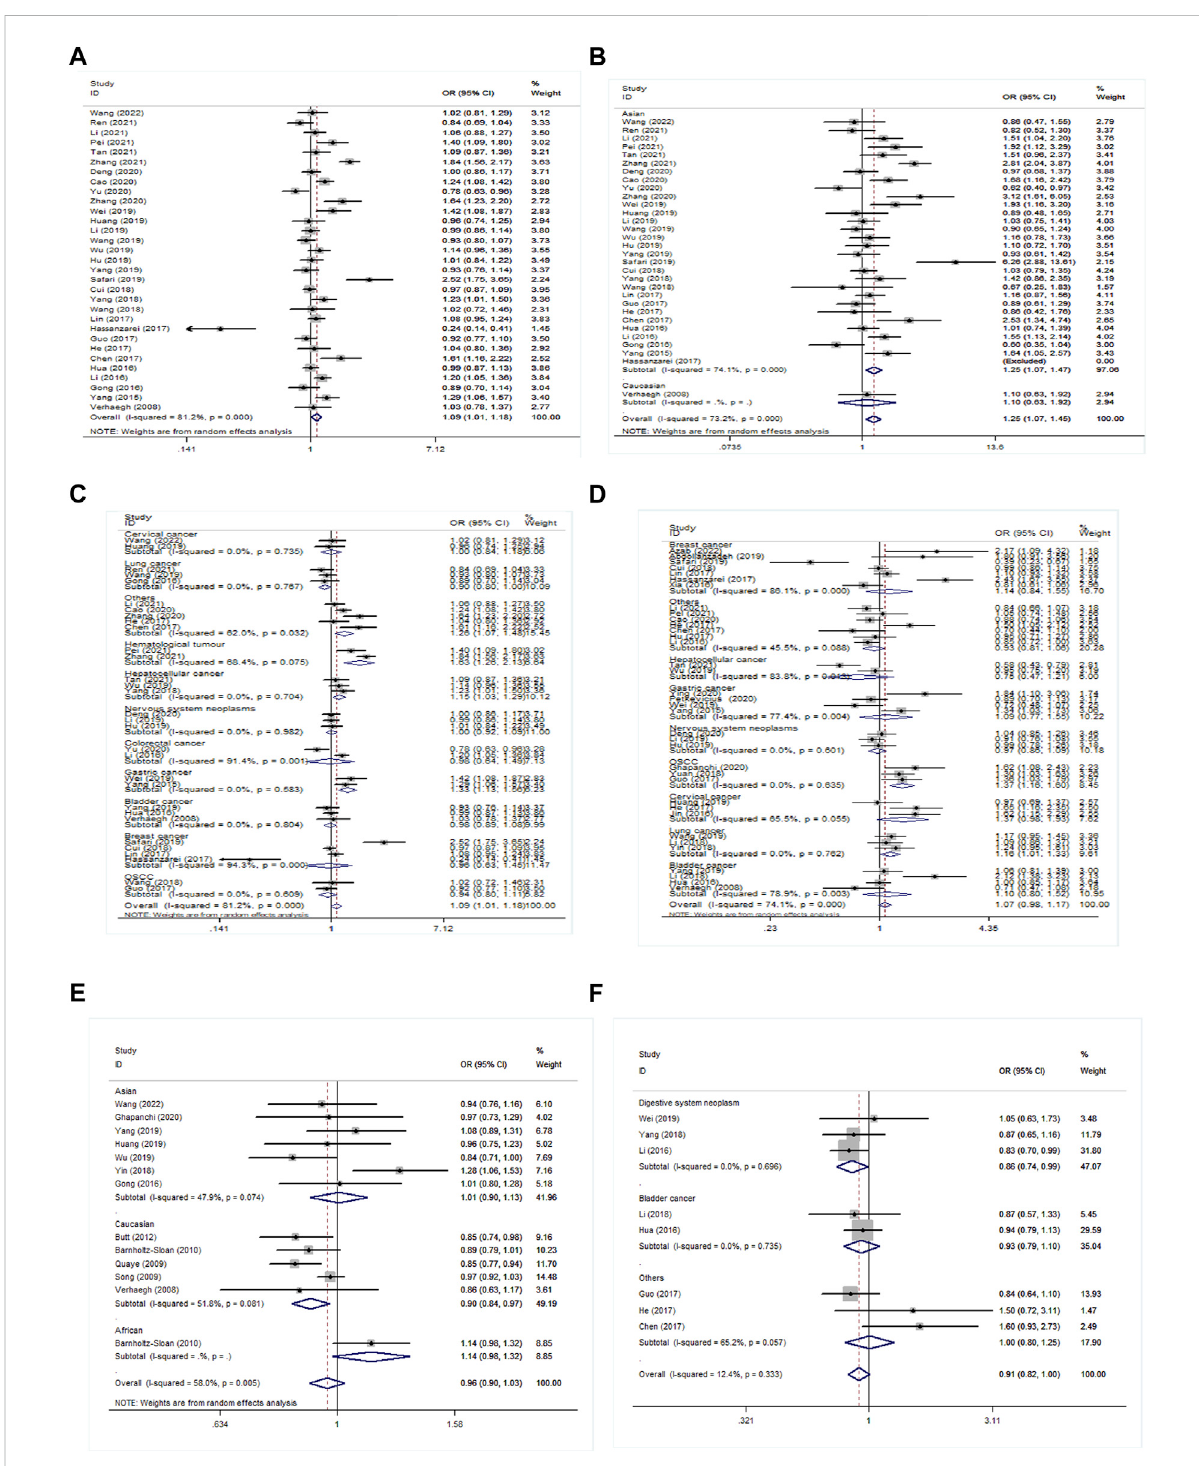
ForestplotfortheassociationbetweenH19polymorphismsandcancersusceptibility. (A) Forestplotforrs2839698polymorphismintheoverall population, A vs G; (B) in ethnicity subgroup, AA vs GG; (C) and in cancer type subgroup, A vs G; (D) for rs217727 polymorphism in cancer type subgroup,AA+AGvsGG; (E) forrs2107425polymorphisminethnicitysubgroup,TvsC; (F) forrs2735971polymorphismincancertypesubgroup,TC vs